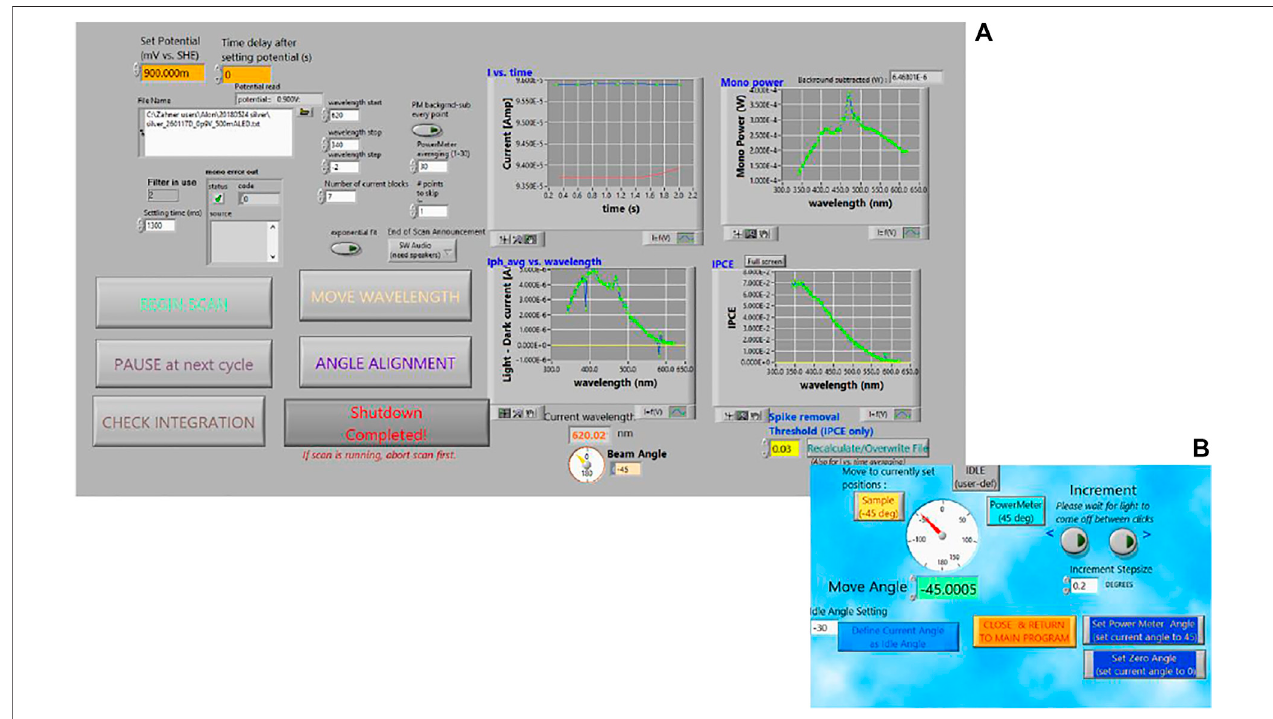
FIGURE 8 | Screenshots of the software interface used for the IPCE system: (A) Interface with scan settings and large buttons for the main, often-used functions, suchasbeginningthescanandpausing.Plotsoftheon-offtransientcurrent,photocurrent(beforeautomaticspikeremoval,whichcanbeuser-speci fi ed),opticalpower, and resultant IPCE spectra update point-by-point during the scan. The large buttons also dynamically display messages such as status messages (like “ setting potential, ” etc.), and/or instructional messages (like “ press to resume scan ” after pausing), or open pop-ups, such as (B) a pop-up window for manual control and calibration of the mirror